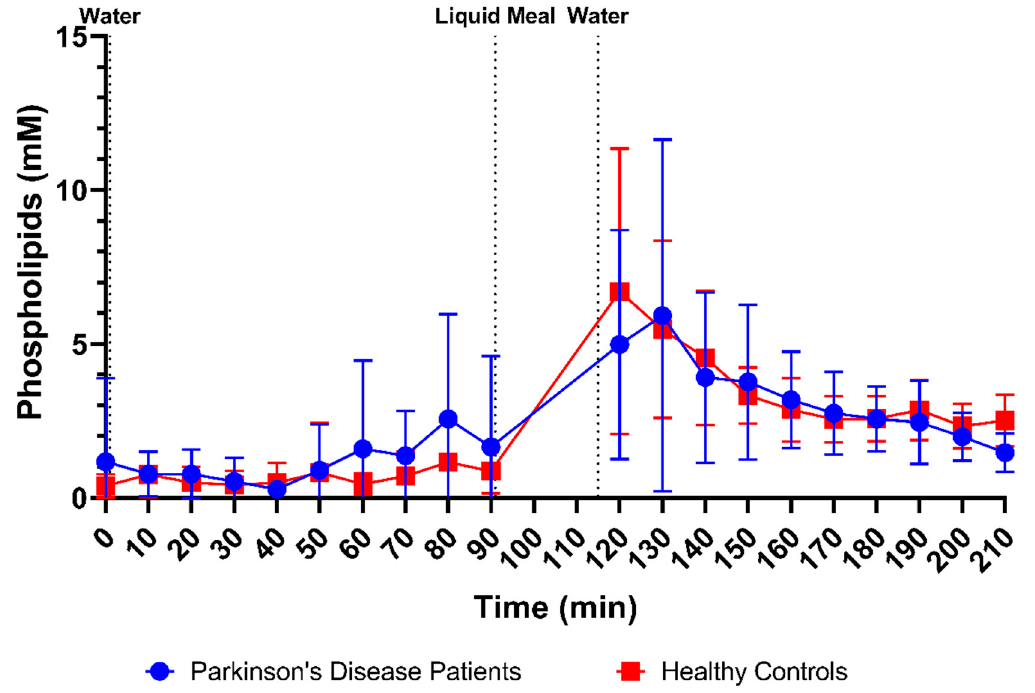
Figure 8. Time-dependent evolution of the phospholipid concentration in duodenal fluids aspirated from Parkinson’s disease patients ( n = 9, blue circles) and healthy controls ( n = 9, red squares). Data points represent the mean ± standard deviation; vertical dotted lines indicate the ingestion of 100 mL of water or 200 mL of liquid meal.